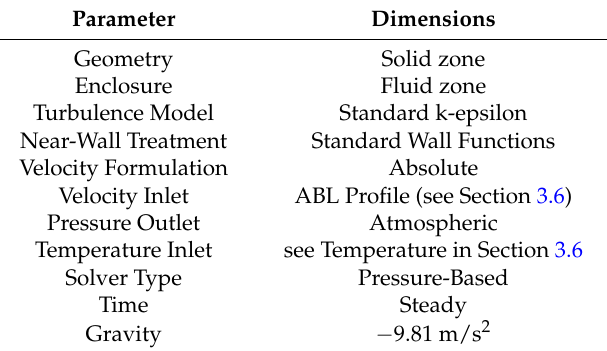
Table 2. Boundary conditions set for the CFD simulation.